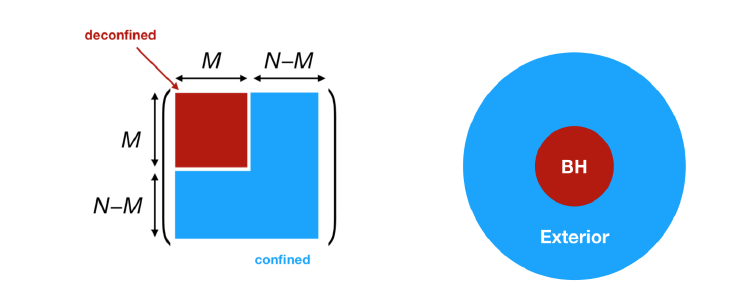
Figure 11 . Figure 4 in ref. [27]. Is it consistent with the interpretation provided in this paper?